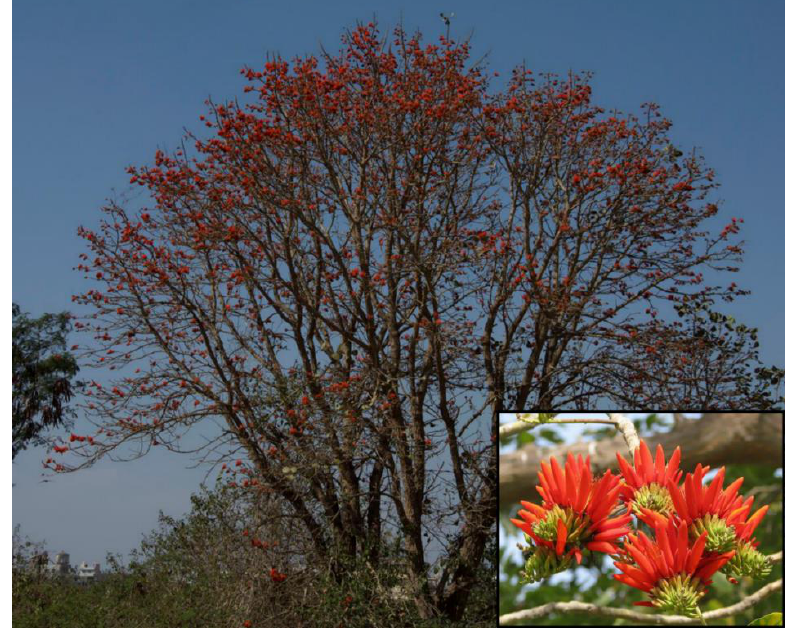
Figure 1. Erythrina suberosa Roxb. tree and flowers.